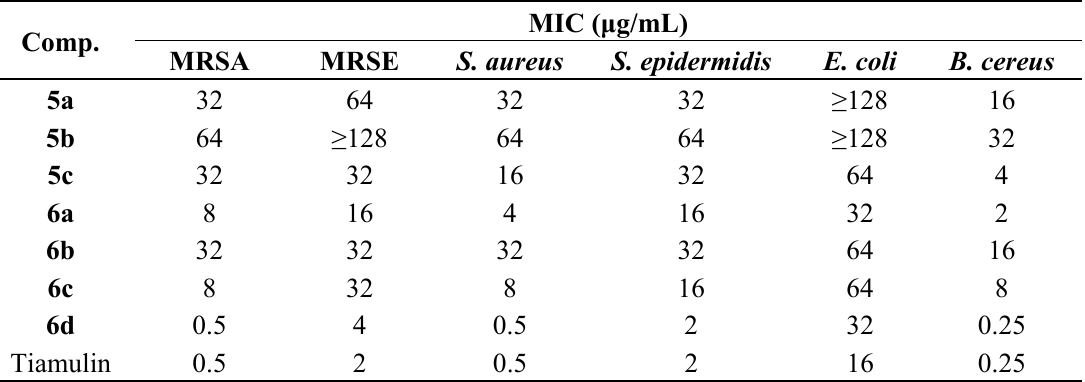
Table 2. Zone of Inhibition for MRSA, MRSE, S. aureus , S. epidermidis , E. coli and B. cereus in mm.